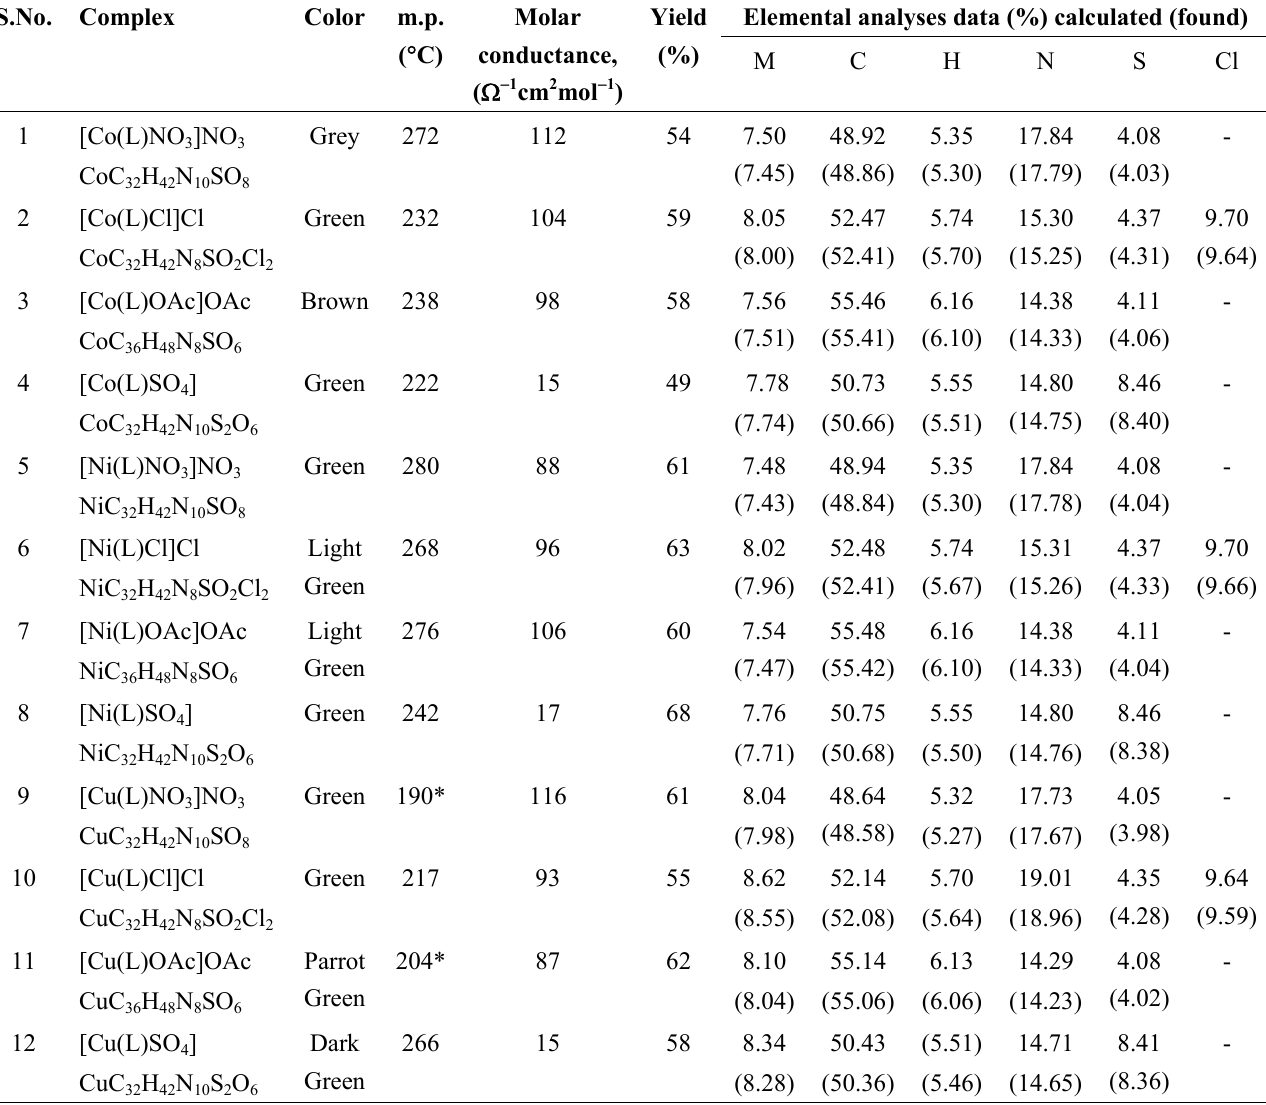
Table 1. Analytical data and physical properties of